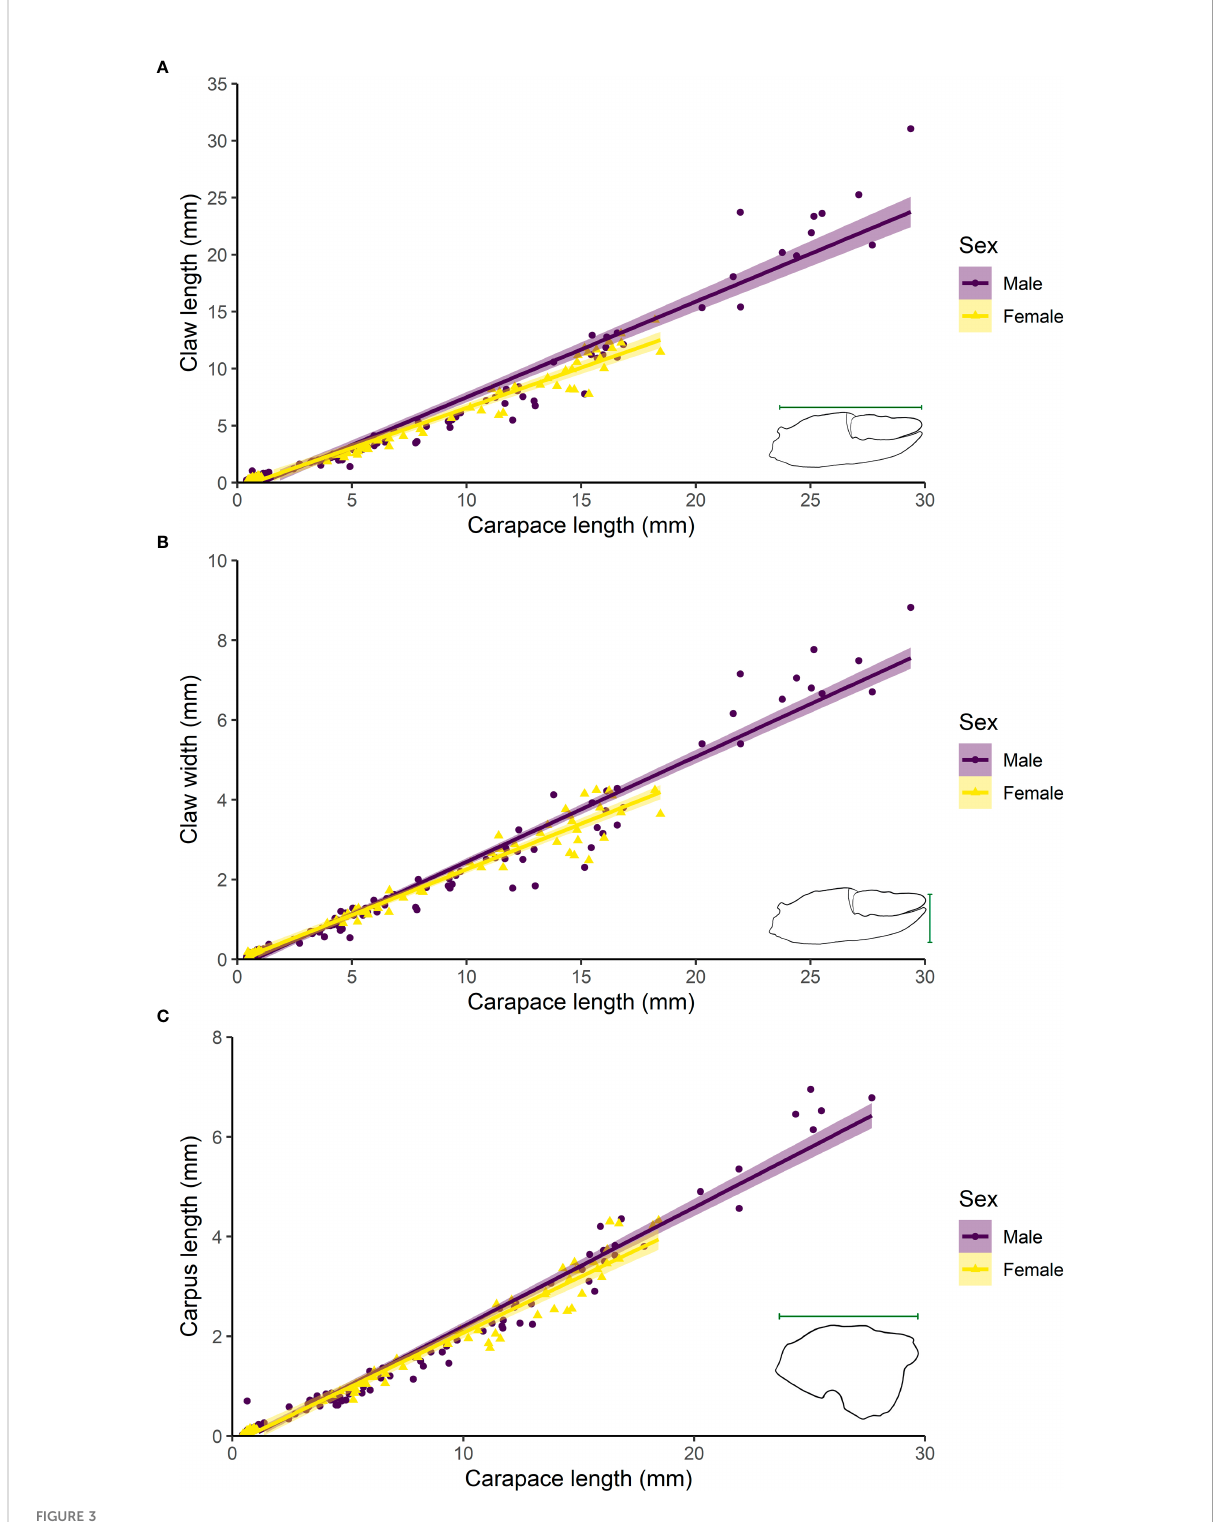
FIGURE 3 Comparison of the relationship of the claw length (A) , claw width (B) , and carpus length of the second pereopod (C) with the carapace length by sex (adult males and females) of Kiwa puravida , 2011 from Mound 12, Costa Rican Paci fi c margin. Data were fi tted in linear regression models, shading represents 95% con fi dence interval around the model fi